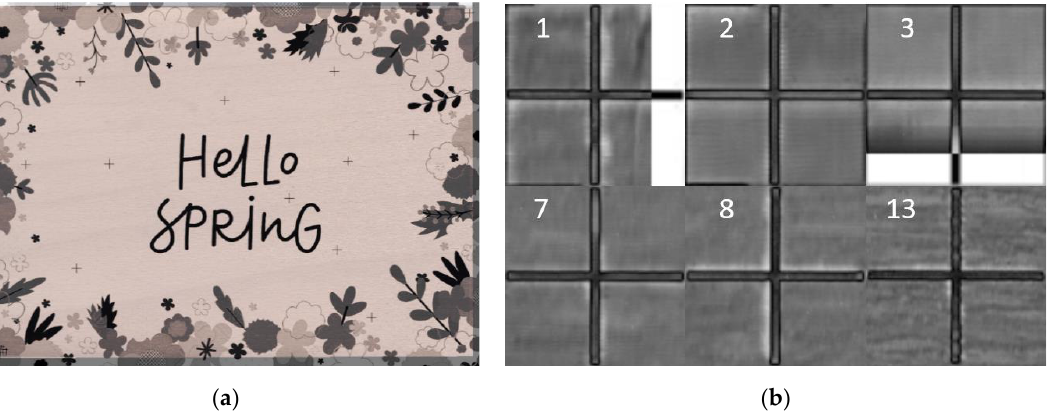
Figure 6. Scanned and source image comparison method: ( a ) Blend method; ( b ) Diff method, zoomed selected landmarks (position of landmarks see Figure